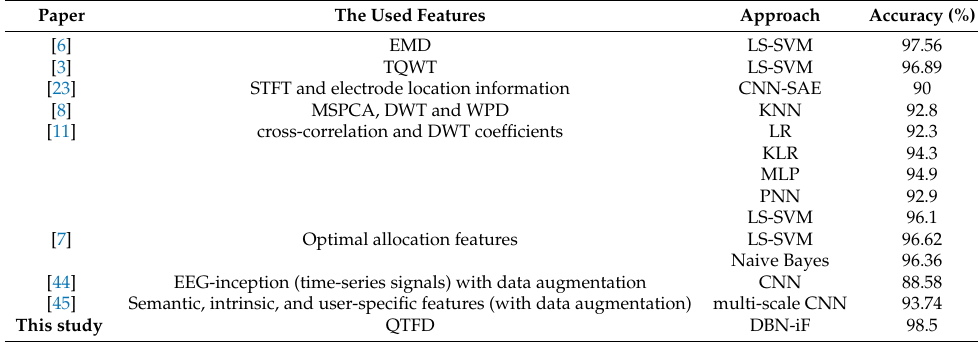
Table 5. Comparison of the proposed method with existing